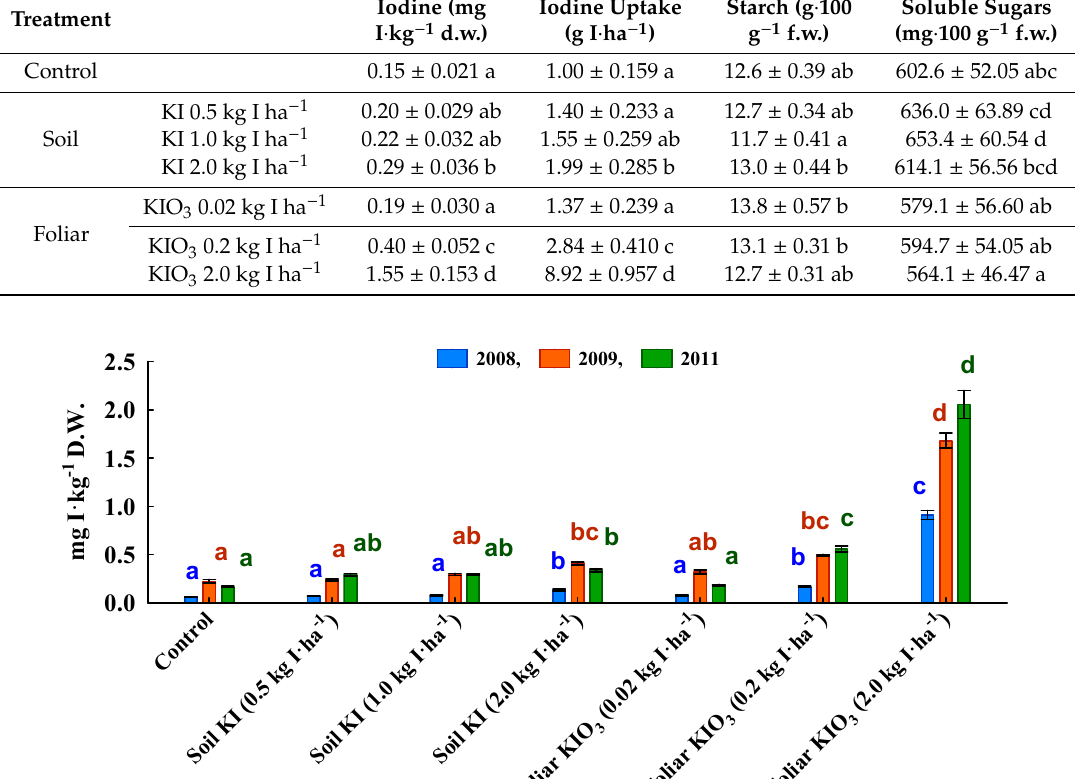
Table 7. Iodine content, iodine uptake by yield of tubers and the content of starch and soluble sugars in potato tubers, means for three years of the study; values ± standard error; values followed by the same letters are not statistically di ff erent at p < 0.05, ( n = 12).